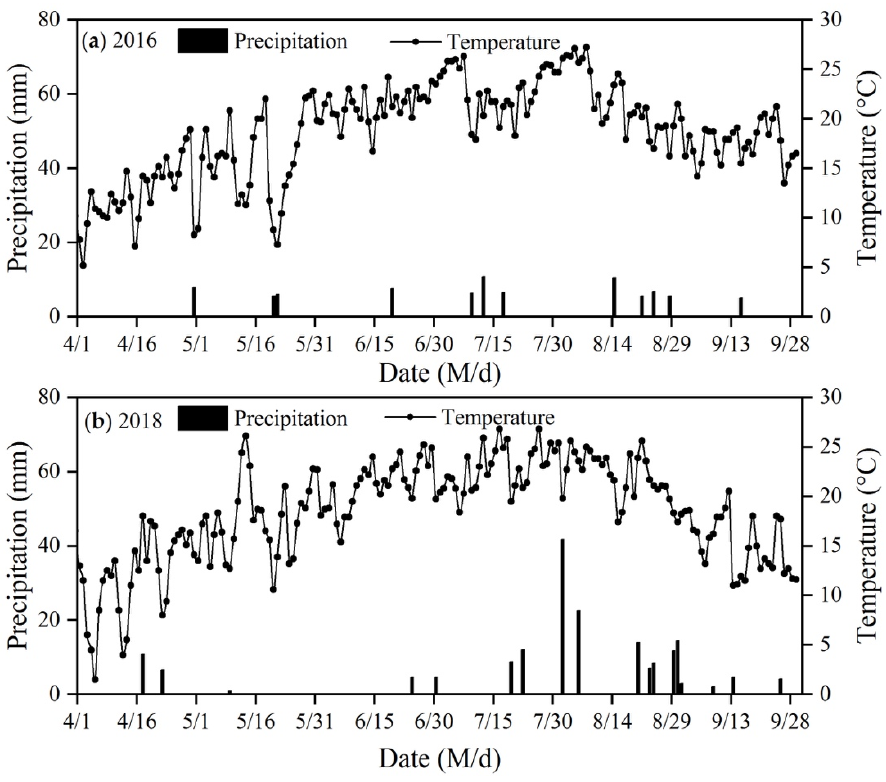
Figure 1. Daily precipitation and average air temperature during the growing season ( a ) in 2016 and ( b ) in 2018 at the Shiyang River Basin Experiment Station, Wuwei City, China.